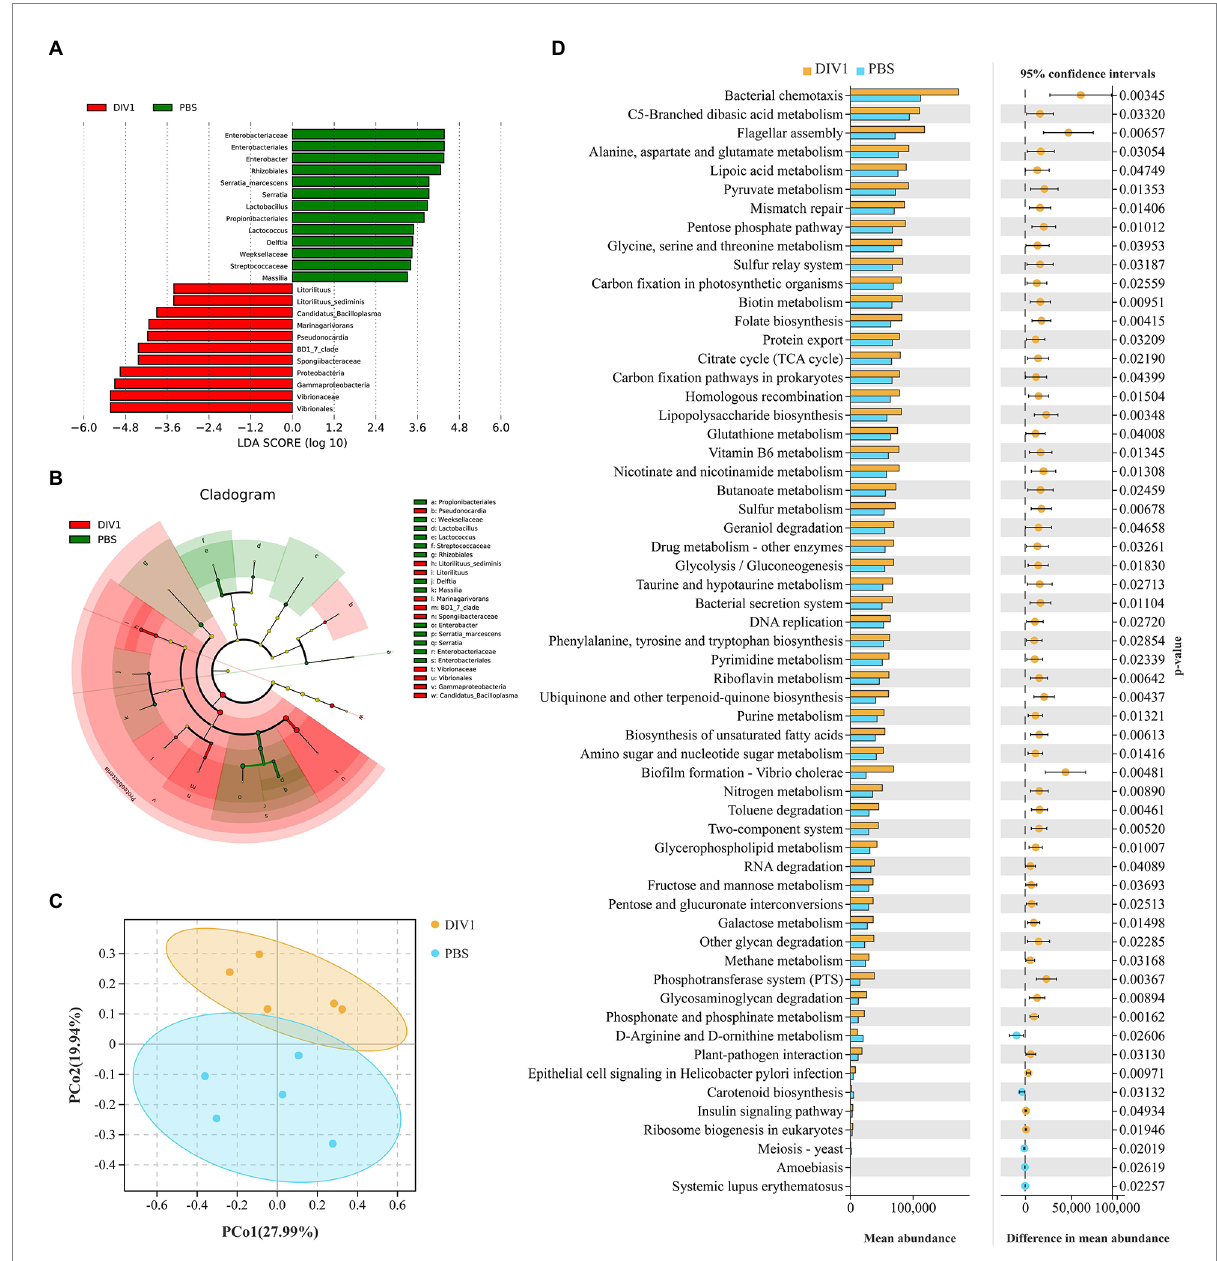
FIGURE 4 Intergroup differences and PCoA in the relative abundance of intestinal microbial communities between DIV1-infected and PBS groups. (A) LDA score of LEfSe. Only taxa with LDA value (influence value of linear discriminant analysis) higher than two were shown. (B) Lefse cladogram. Evolutionary branch graph of differential bacterial communities or species. Green: bacterial taxa enriched in PBS group; red: bacterial taxa enriched in DIV1 group; yellow: no significant differences. (C) PCoA plot shows the microbial diversity of samples. Samples from the same group were clustered closer. (D) Differential functional information between DIV1-infected and PBS groups (KEGG level 3). The left half of the figure: the y-axis represents the differential function, and x-axis represents the abundance of the differential function. The right half of the figure: the x-axis shows the confidence interval range of functional abundance difference between groups, colour indicates the grouping of high abundance, and the y-axis is the p